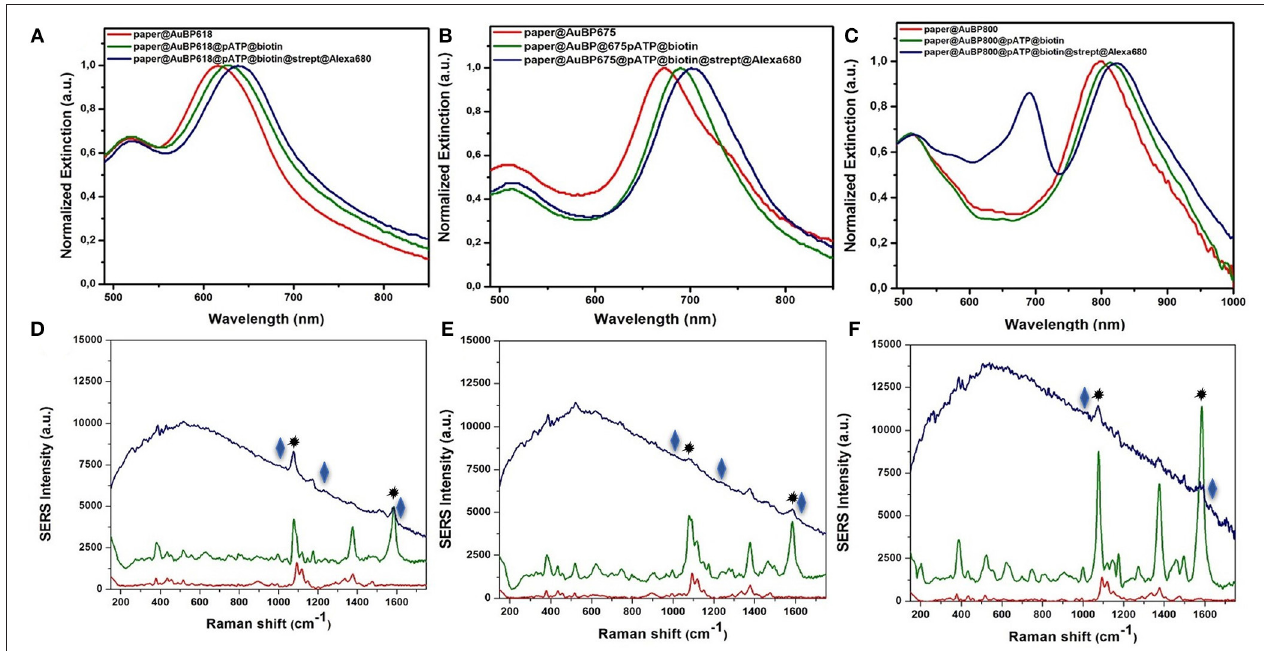
FIGURE 4 | Normalized extinction spectra (A–C) together with the recorded SERS spectra (D–F) of the as-designed paper-based plasmonic nanoplatforms with tunable plasmonic response at paper@AuBP 618, paper@AuBP 675, and paper@AuBP 800, respectively (red spectra), after their biotinylating process (green spectra), and after the specific capture of target streptavidin (blue spectra), proving the capability of our nanoplatforms for dual LSPR-SERS detection. Excitation: 785nm laser line.